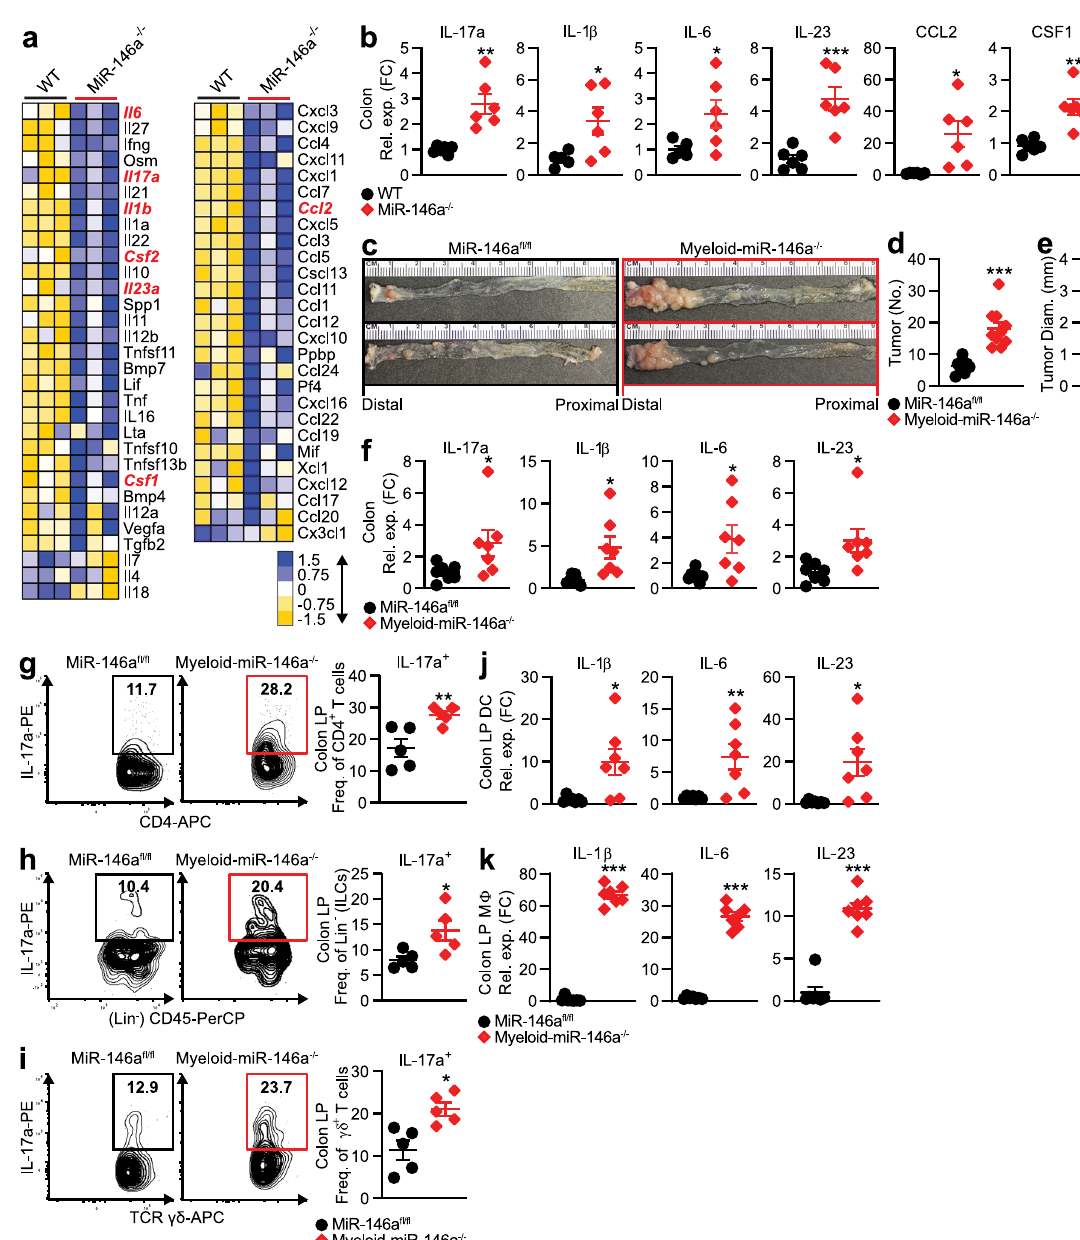
Fig. 2 Myeloid cell-speci fi c deletion of miR-146a promotes CRC development. a In fl ammatory Cytokines and Receptors RT2 Pro fi ler PCR Array (Qiagen) in distal colon from colitic WT and miR-146a − / − mice ( n = 3). b qPCR of IL-17 and IL-17-promoting cytokines in CRC tissue from WT and miR-146a − / − mice with AOM/DSS-induced CRC ( n = 6 – 7). c – e Representative images ( c ), numbers ( d ), and sizes ( e ) of colonic tumors in miR-146a fl / fl and myeloid- miR-146a − / − (LysM Cre miR-146a fl / fl ) mice with AOM/DSS-induced CRC ( n = 8 – 10). f qPCR of IL-17 and IL-17-inducing cytokines in CRC tissue from miR- 146a fl / fl and myeloid-miR-146a − / − mice ( n = 7). g – i Representative FACS plots and frequencies of IL-17a in CD4 + T cells (Th17) ( g ), (Lin − CD45 + ) ILCs ( h ), and (CD3 + δ + ) γδ + T cells ( i ) from the colonic LP of miR-146a fl / fl and myeloid-miR-146a − / − mice with AOM/DSS-induced CRC ( n = 5). j , k qPCR of IL-17-inducing cytokines in CD11c + DCs ( j ) and CD11b + M Φ s ( k ) from the colonic LP of CRC miR-146a fl / fl and myeloid-miR-146a − / − mice ( n = 7). qPCR data as FC from WT or miR-146a fl / fl ( b , f , j , k ). Data are representative of ≥ 2 independent experiments. n = biologically independent replicates per group. Mean ± SEM. * p < 0.05, ** p < 0.01, *** p < 0.001, by two-tailed Student ’ s t -test ( b , d – k ). Source data are provided as a Source data fi